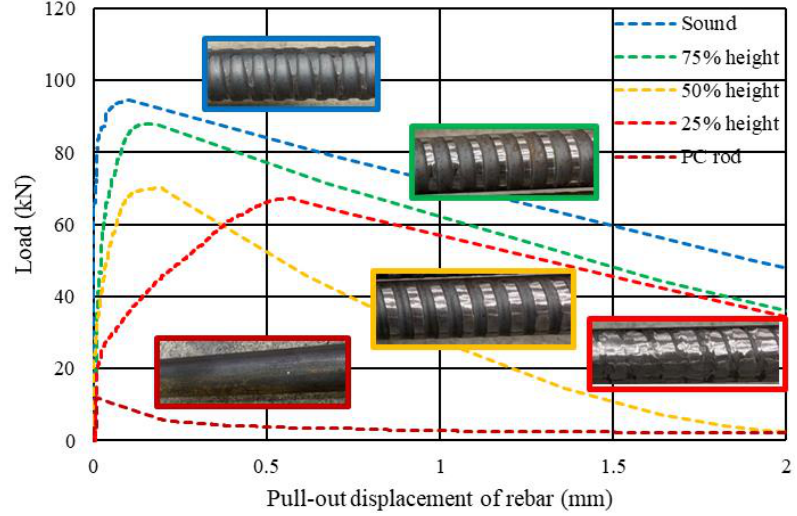
Figure 14. Pull-out test results.